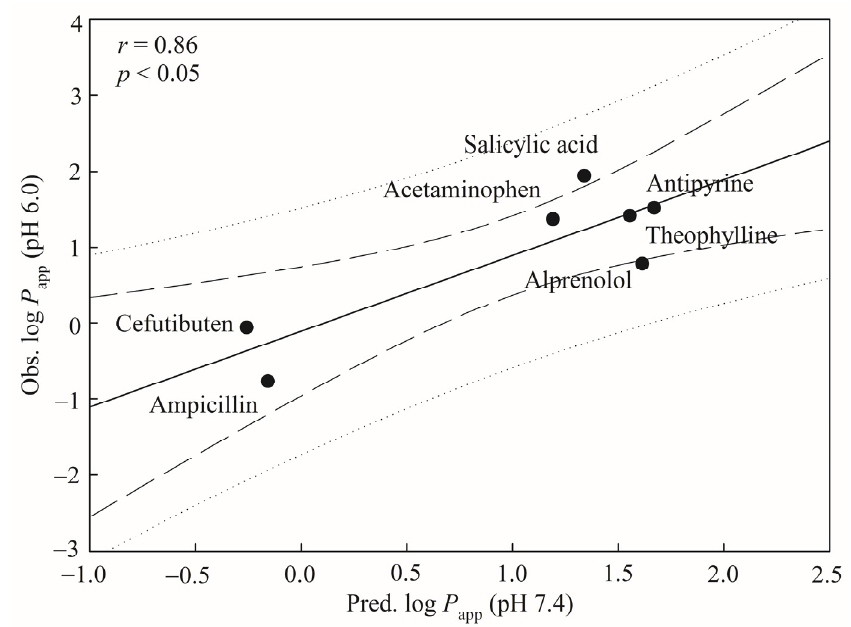
Figure 7. Predicted log P app at pH 7.4 versus observed log P app at pH 6.0 by the HSVR model for the drugs in the mock test. The solid, dashed, and dotted lines represent the HSVR regression data, 95% confidence interval for the HSVR regression, and 95% confidence interval for prediction, respectively.